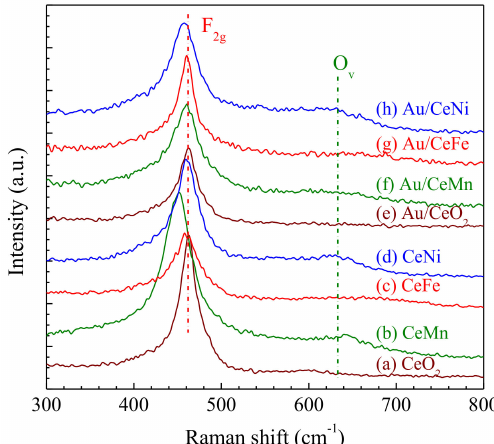
Figure 4. Raman spectra of CeO 2 , CeM mixed oxides with different dopants and corresponding supported Au/CeM catalysts: ( a ) CeO 2 ; ( b ) CeMn; ( c ) CeFe; ( d ) CeNi; ( e ) Au/CeO 2 ; ( f ) Au/CeMn; ( g ) Au/CeFe; ( h )